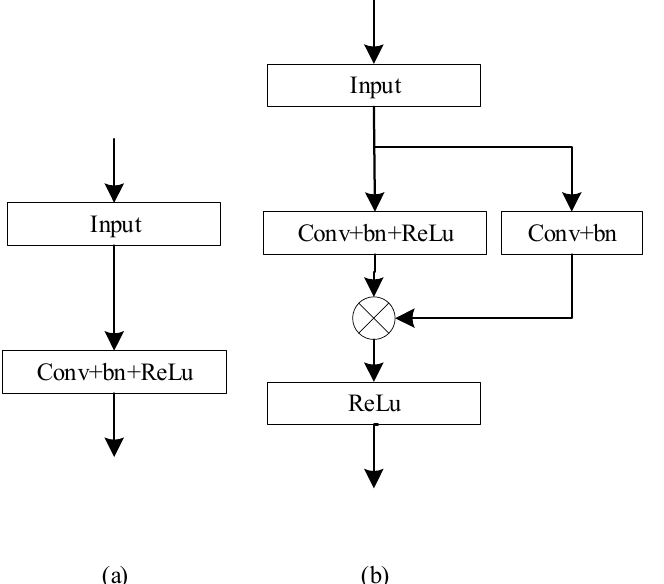
Figure 4. Before and after the introduction of the RCB module: ( a ) traditional network; ( b ) residual network.